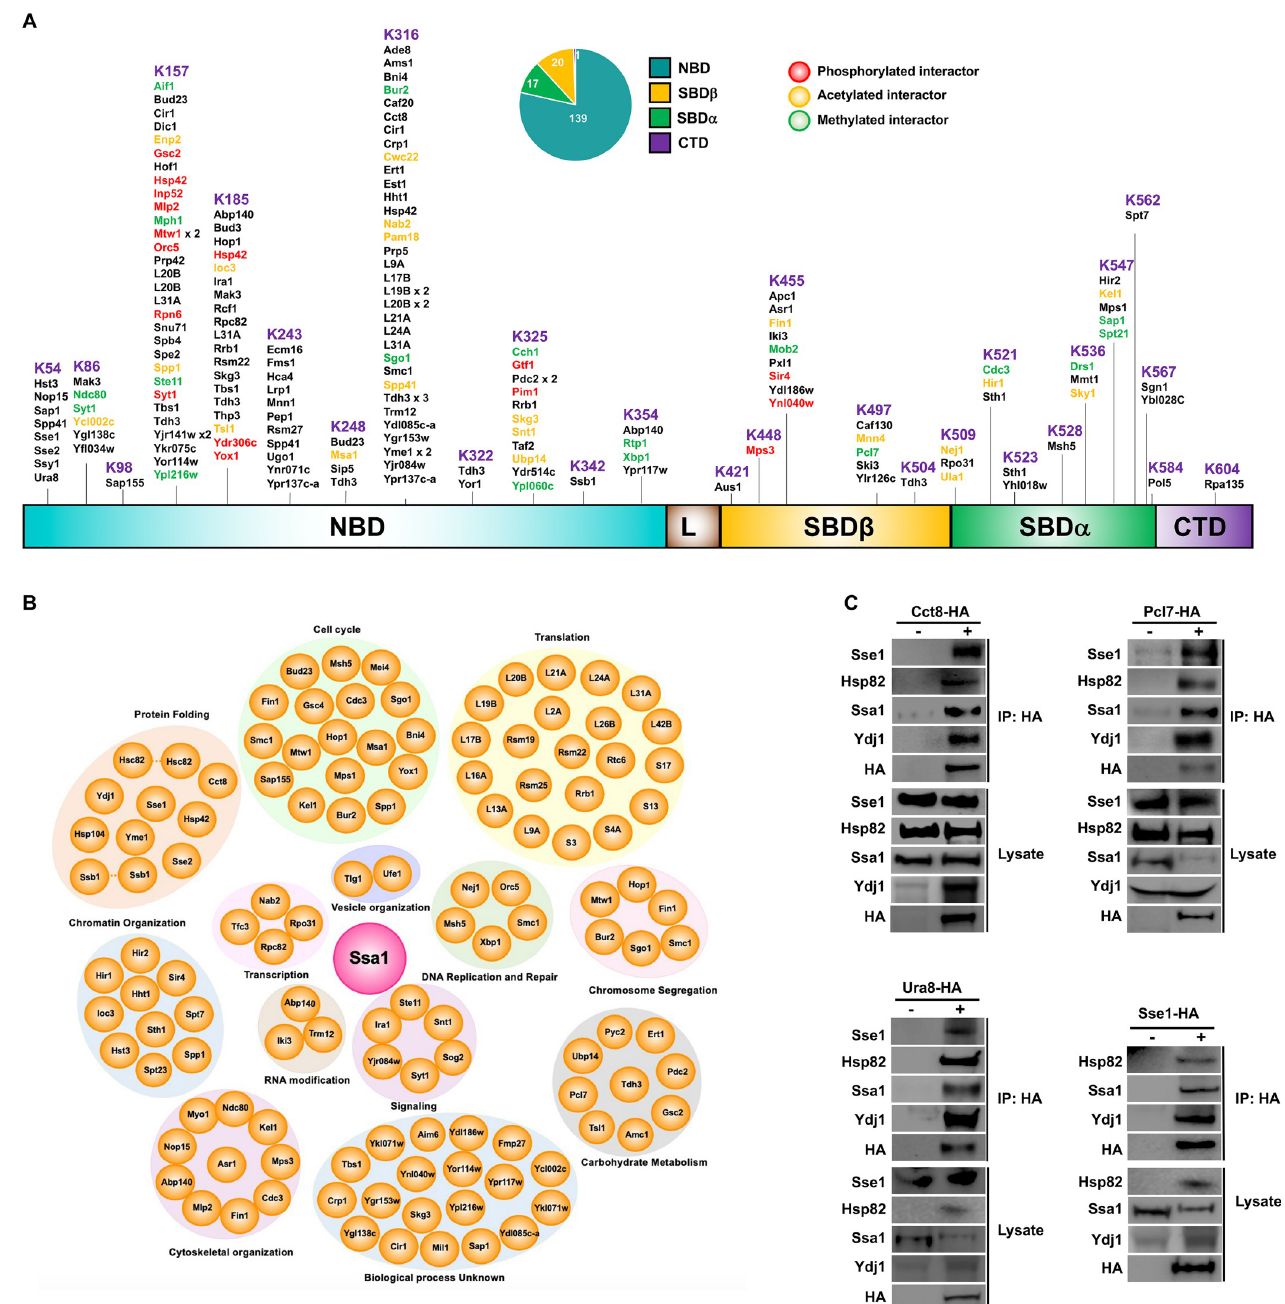
Fig 3. Direct interactors of yeast Hsp70 identified by XL-MS. (A) Schematic representation of 177 inter protein cross-links and identified PTMs of direct interactors on domains of Hsp70. (B) Functional classification of direct Hsp70-protein peptides. (C) Western blot analysis of HA-tag immunoprecipitated Cct8, Pcl7, Ura8, and Sse1 from yeast cells. CTD, C-terminal domain; NBD, nucleotide-binding domain; PTM, posttranslational modifications; SBD, substrate- binding domain; XL-MS, cross-linking mass spectrometry.